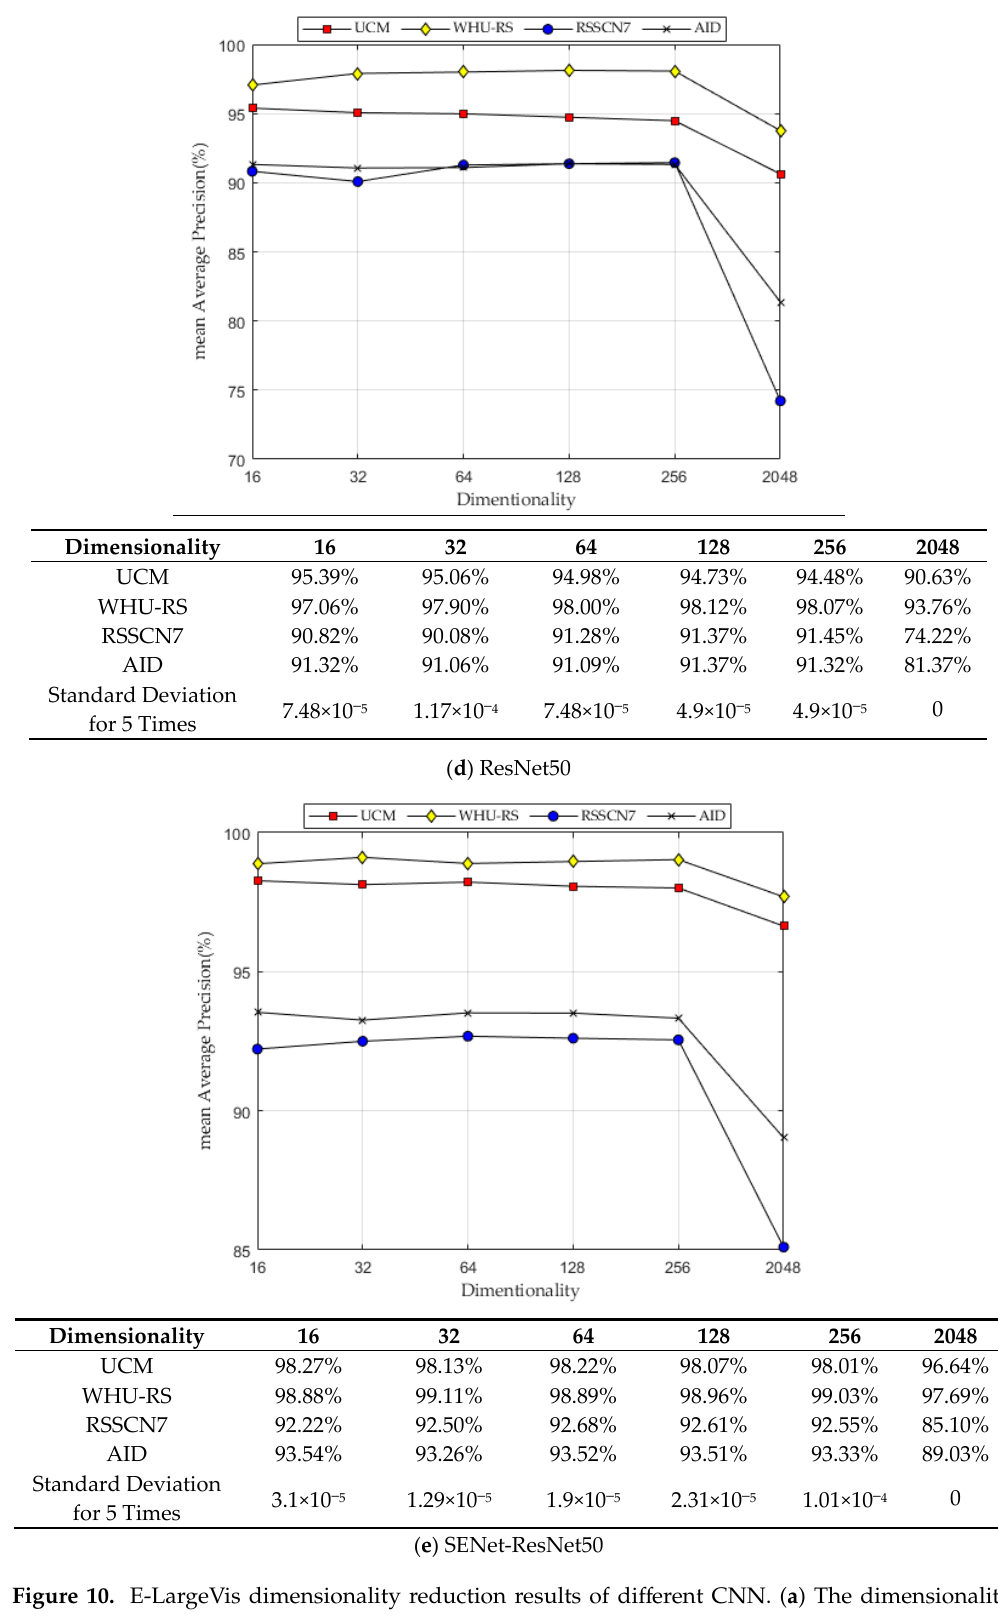
Figure 10. E-LargeVis dimensionality reduction results of di ff erent CNN. ( a ) The dimensionality reduction results of AlexNet. ( b ) The dimensionality reduction results of VGG-16. ( c ) The dimensionality reduction results of GoogLeNet. ( d ) The dimensionality reduction results of ResNet50. ( e ) The dimensionality reduction results of